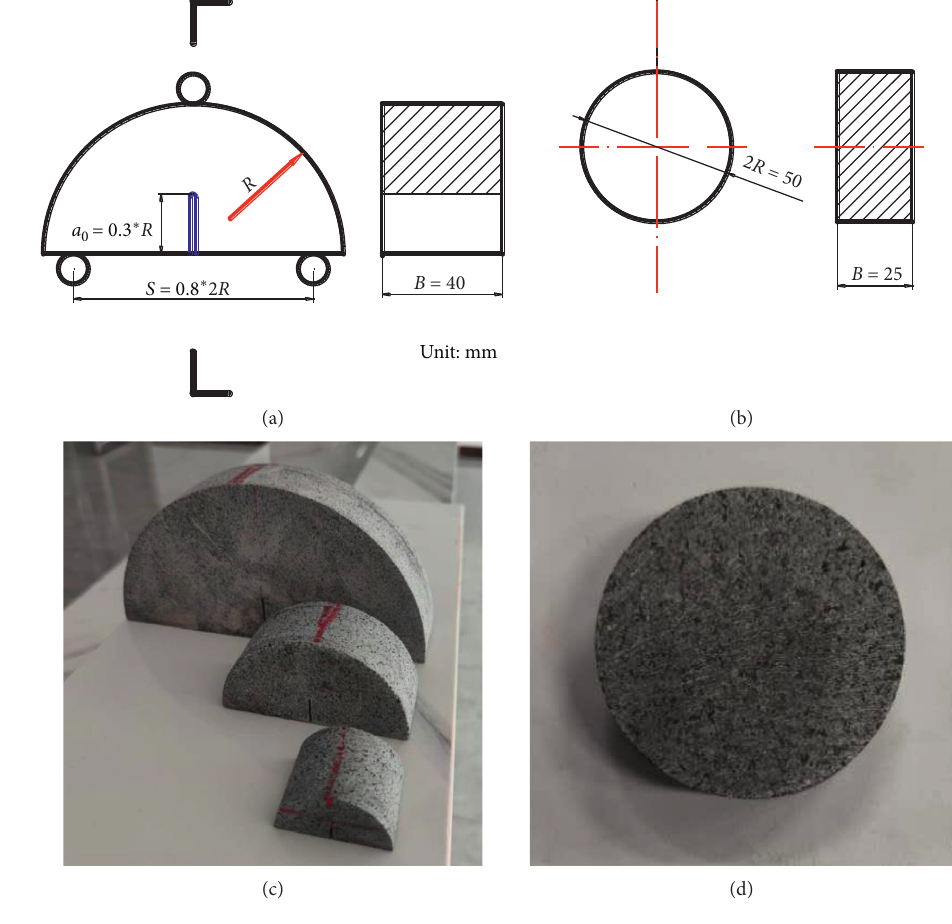
Figure 2: SCB specimens and BD specimens. Table 1: Detailed geometric dimensions of the